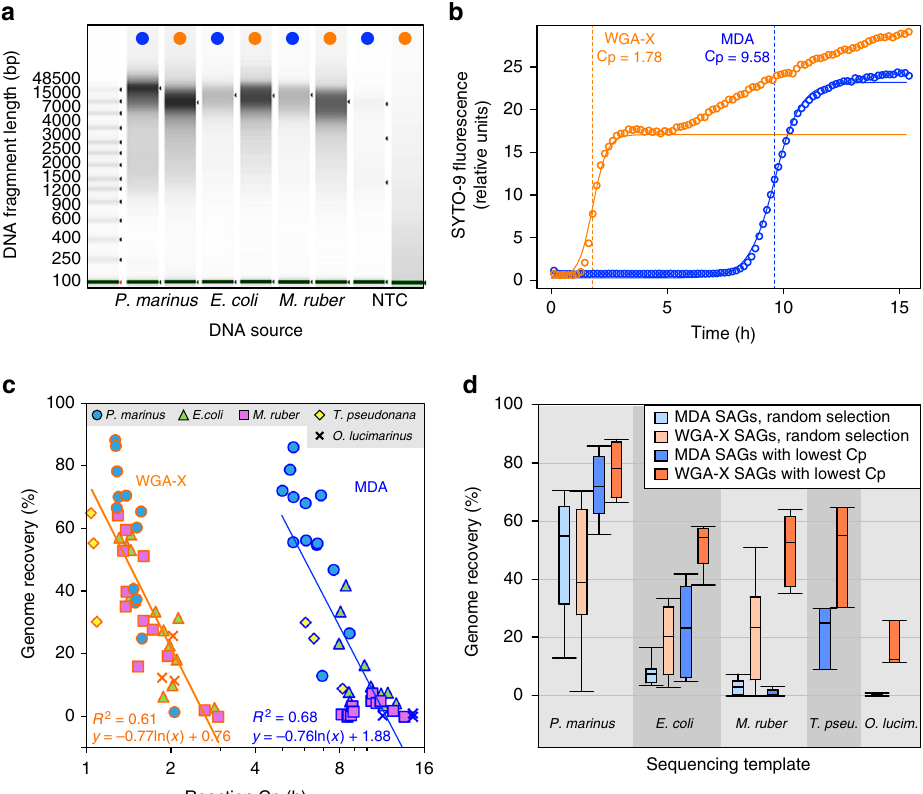
Fig. 1 Comparison of WGA-X and MDA performance with microbial benchmark strains. a Electrophoresis gel images of WGA-X ( orange dots ) and MDA ( blue dots ) products obtained from three bacterial benchmark strains and from no-template negative controls ( NTC ). b Examples of WGA-X and MDA reaction kinetics, where reaction critical point ( Cp ) is estimated as the time required to reach the in fl ection point of the reaction ’ s exponential phase. c Correlation between reaction Cp and genome recovery from SAGs. d Average, standard deviation, and range of genome recovery from SAGs of the fi ve benchmark strains, where SAGs were selected either at random or based on their lowest Cp values. In c and d , each bacterial strain data set derives from eight randomly selected SAGs and fi ve SAGs with the lowest Cp; each eukaryote data set derives from three SAGs with the lowest Cp. Assemblies of bacterial and eukaryote SAGs were produced from fi ve million and twenty million of 2 × 150 bp reads,